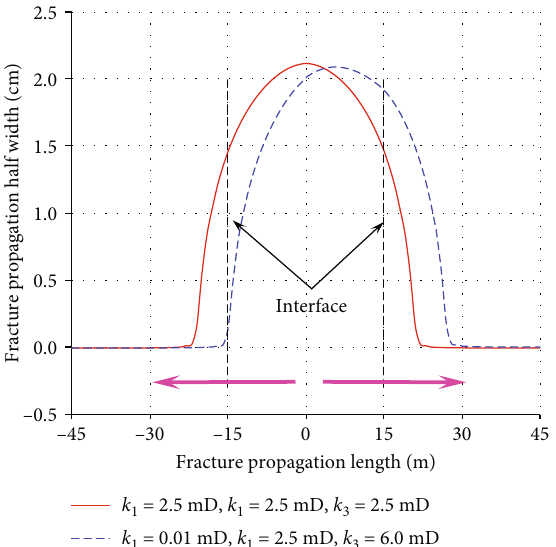
Figure 15: E ff ect of formation permeability contrast on the fracture propagation geometry.